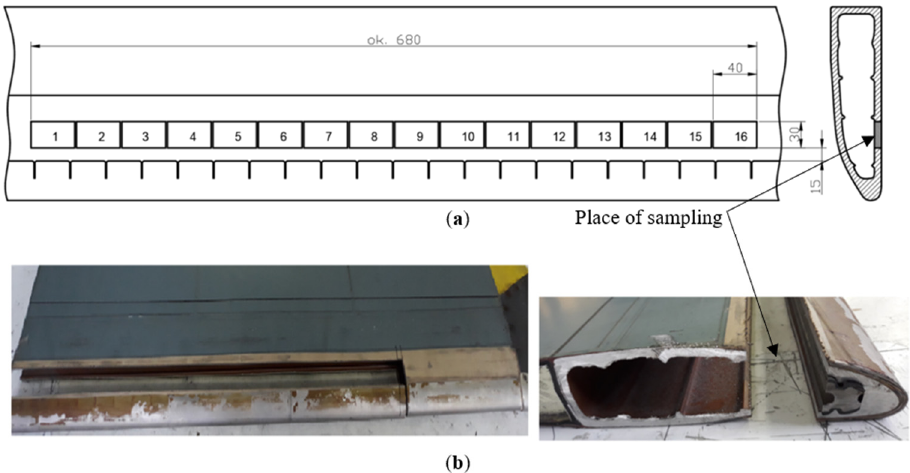
Figure 13. Place from where the spar fragments were extracted: ( a ) scheme of spar; ( b ) Mi-8 rotor blades after collecting samples.